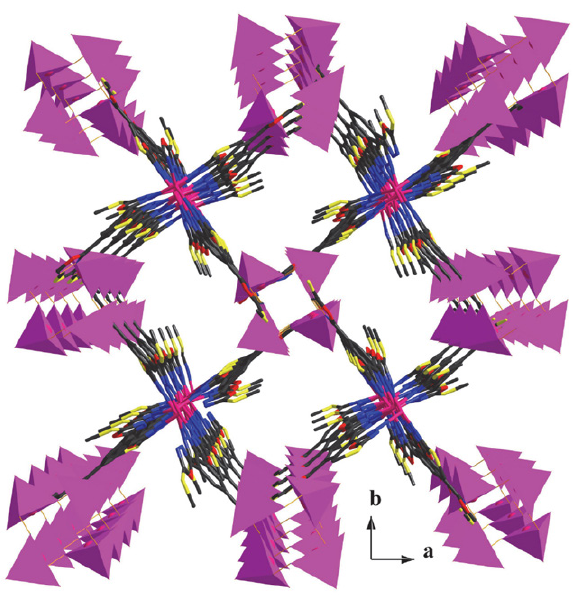
Figure 4. 3D framework of 1 (anions and CH 2 Cl 2 molecules are omitted for clarity), and Ag2 centers are highlighted as fuchsia pol-